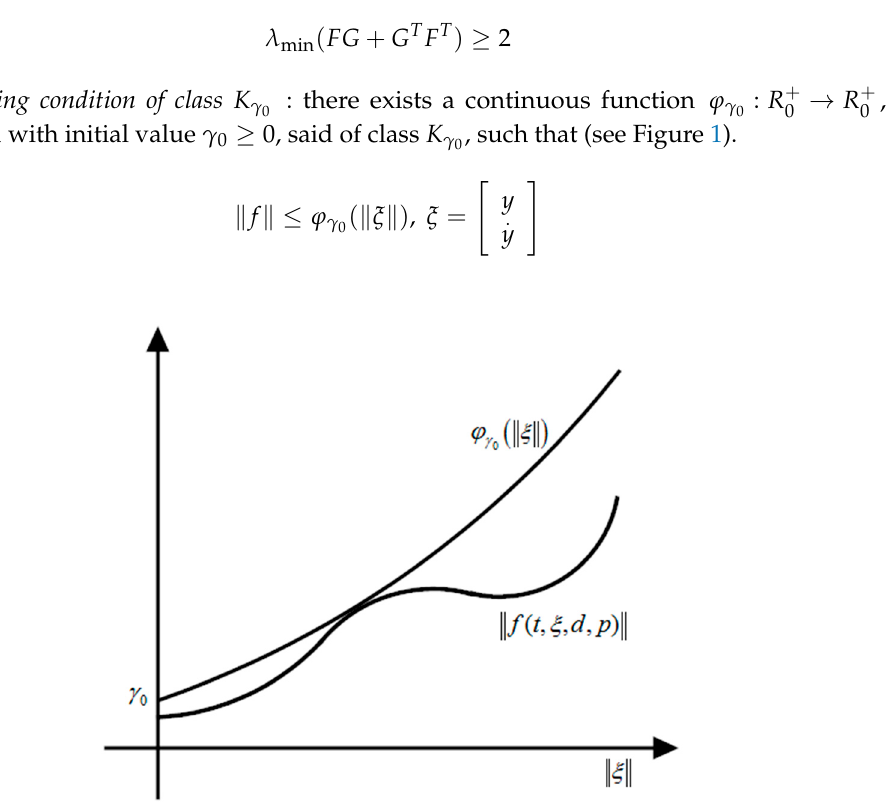
Figure 1. Illustration of the bounding condition for f of class K